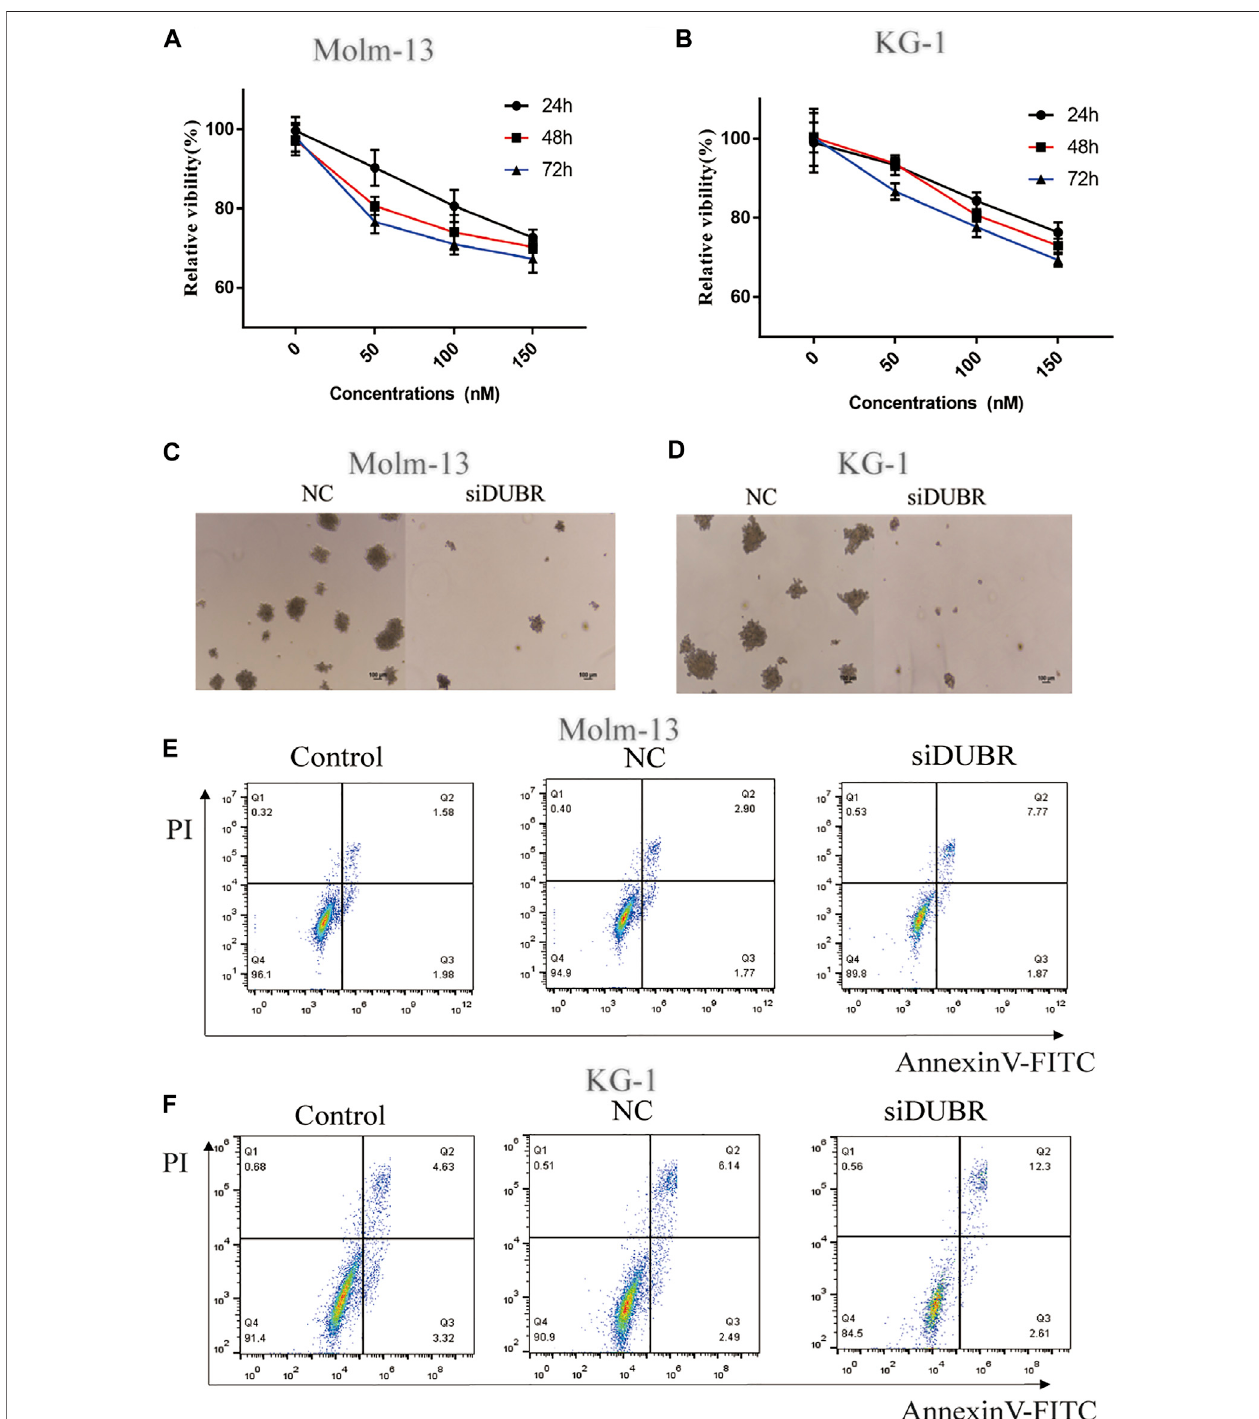
FIGURE 4 | DUBR induces the promotion of cell viability and inhibition of apoptosis in AML cells. Cell growth in control and DUBR -knockdown (using siDUBR ) Molm-13 (A) andKG-1cells (B) wasmeasuredusingcellcountingkit-8assay.Downregulationof DUBR by DUBR -siRNAinhibitedthecolony-formingabilityofMolm-13 (C) and KG-1 cells (D) . Apoptosis rate in Molm-13 (E) and KG-1 cells. (F) assessed using fl ow cytometry.